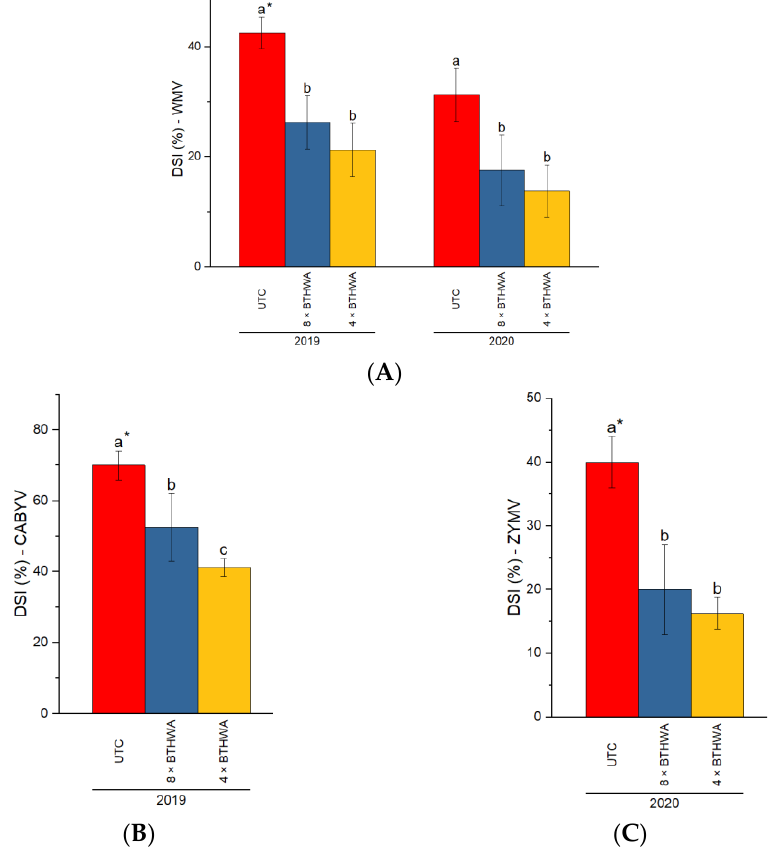
Figure 1. The Disease Severity Index (DSI%) for zucchini ( Cucurbita pepo convar. giromontiina) infected with WMV ( A ), CABYV ( B ), and ZYMV ( C ). Statistical differences appeared between the plants subjected to different variants of treatments in respective years (treatment × years). * means followed by different letters indicates a statistically significant difference at p < 0.05 according to Tukey’s HSD ( n = 4). UTC — Untreated Control plants that were not treated with BTHWA, 8 × BTHWA — plants that were treated with BTHWA eight times, 4 × BTHWA — plants that were treated with BTHWA four times.